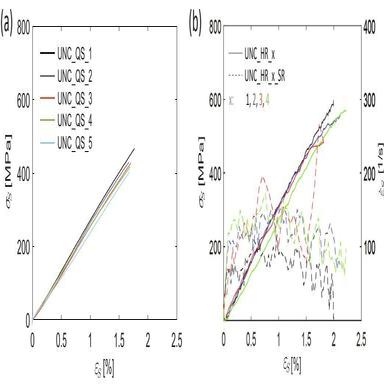
Compressive stress-strain curves in the longitudinal direction for QS (a) and HR (b) loading.